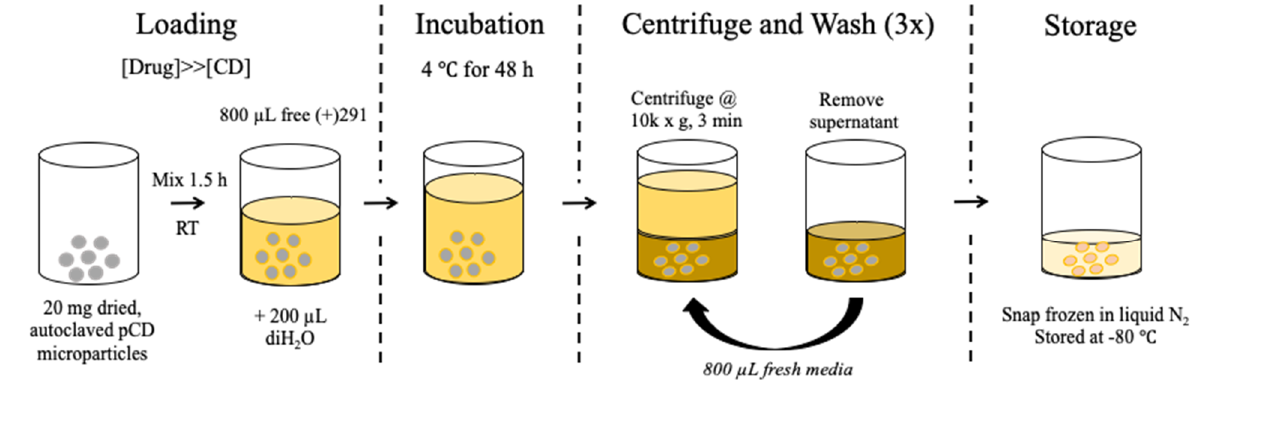
Figure 1. Loading protocol schematic for creating SW033291-loaded β-CD MPs. Prolonging loading to 72 h helps ensure the complexation of SW033291 within the cyclodextrin hydrophobic